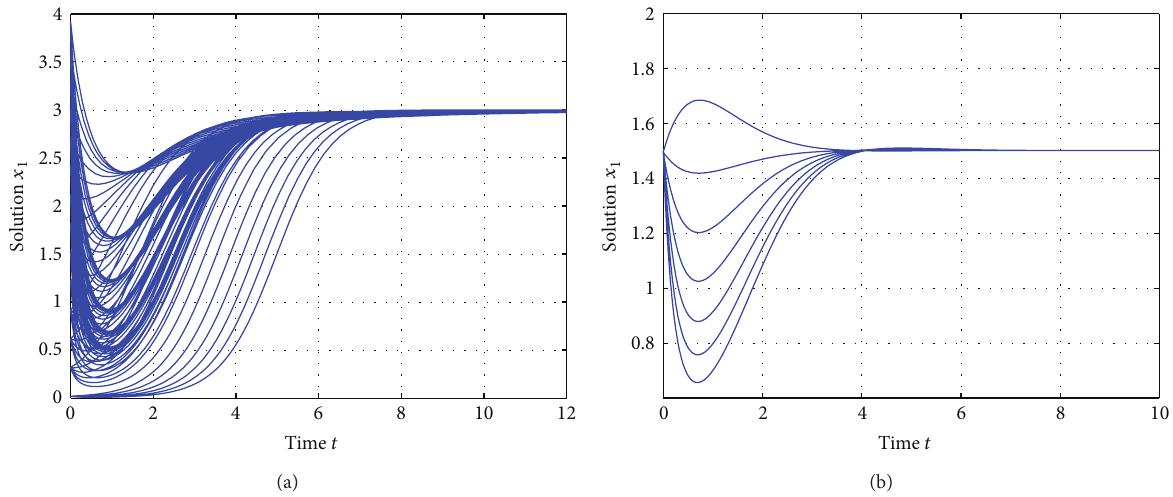
Figure 2: The trajectory of the prey 𝑥 1 of model (30) with (a) 𝑏 1 = 1.5 and 𝜏 = 0 ; (b) 𝑏 1 = 1.5 , 𝜏 ̸=0 , and 𝑥 𝑑 = (1.5,0.5) .